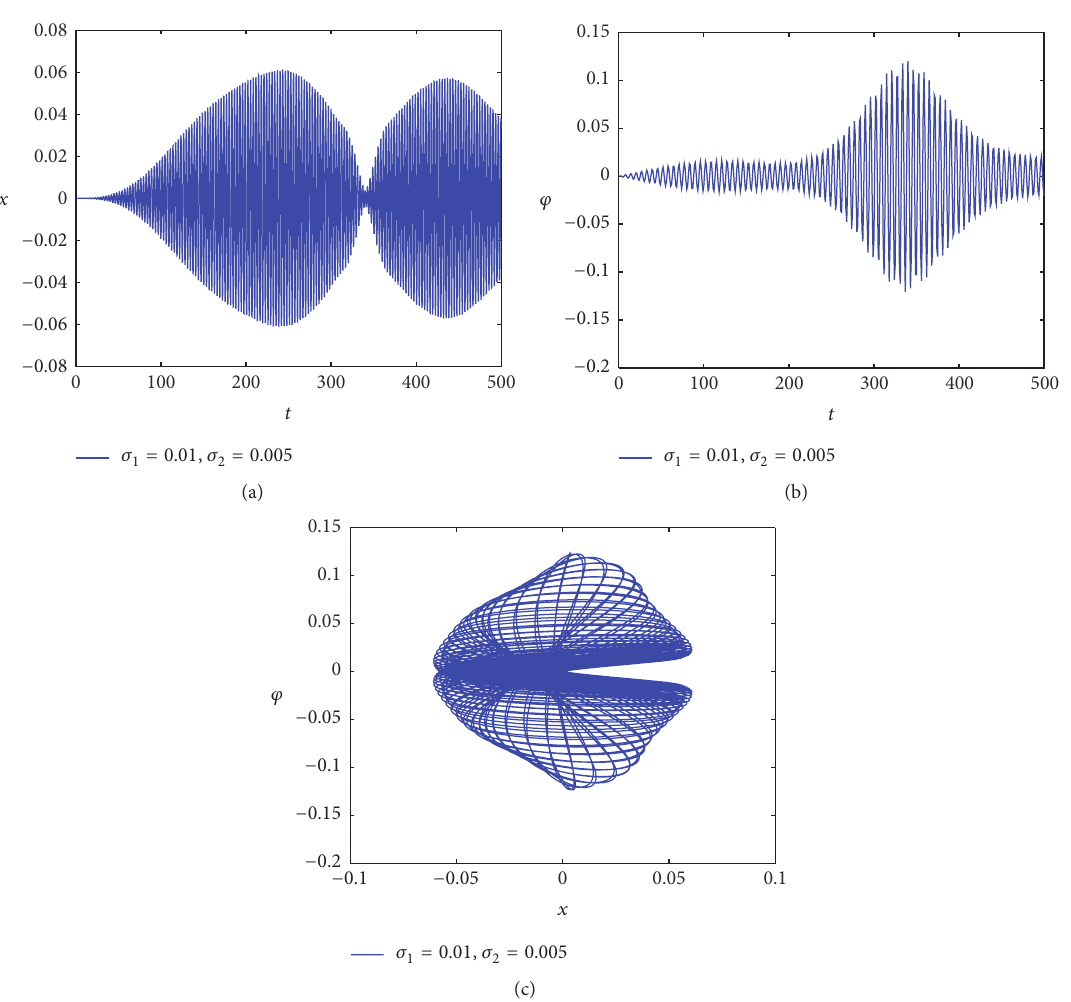
Figure 16: Parts (a) and (b) illustrate the portraits of time history, while part (c) displays the variation of the attained solutions 𝑥 and 𝜑 when 𝑏 = 0